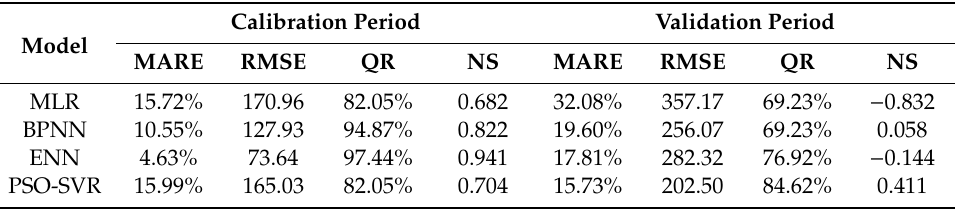
Table 4. Evaluation indexes of four runo ff forecasting models (note: MARE, RMSE and QR represent mean absolute relative error, root mean squared error, and qualified rate, respectively).